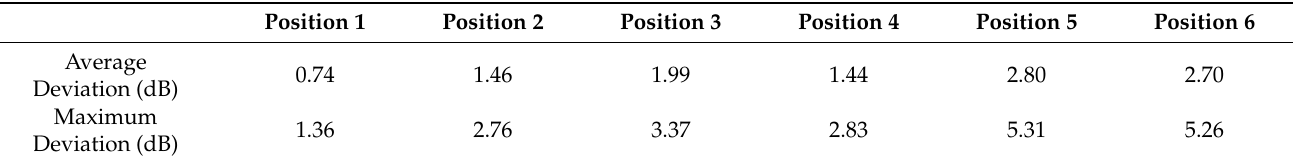
Table 1. Overview of the average and maximum deviation between the SDR, WAVES1, WAVES2 and S 3 R